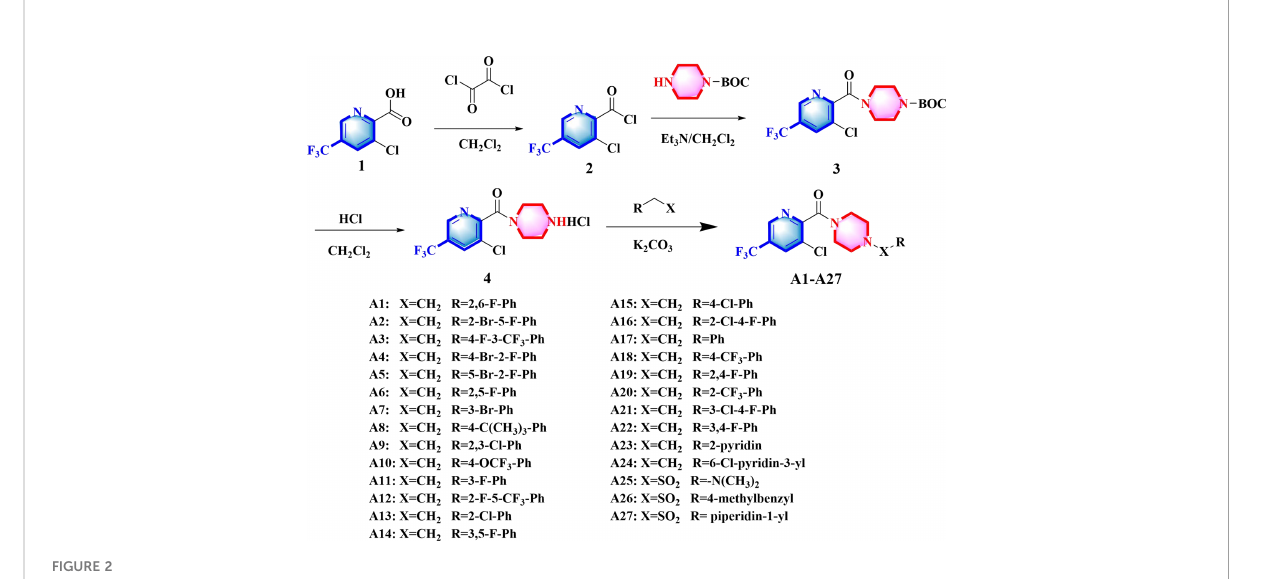
FIGURE 2 Synthesis of compounds A1 − A27